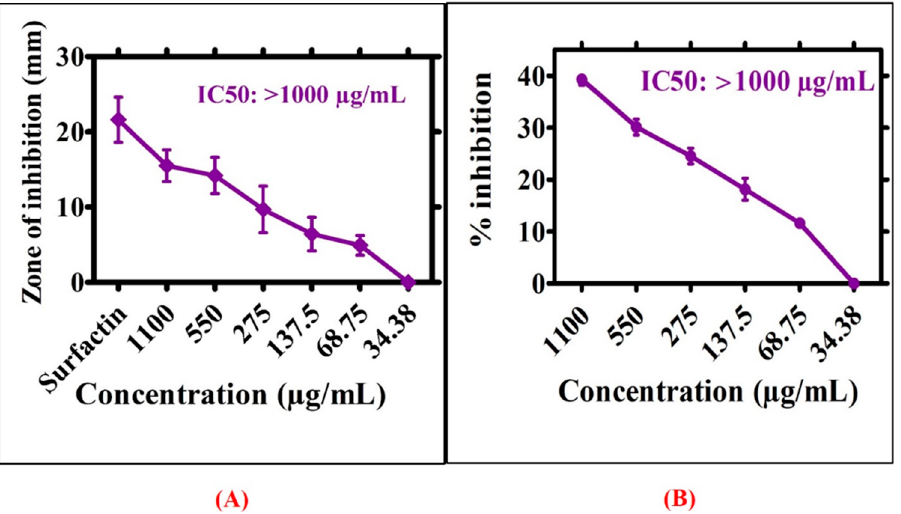
Figure 9. ( A ) Inhibition potential against protein kinase of RT orchestrated NiONPs ( B ) Inhibition potential against alpha amylase.